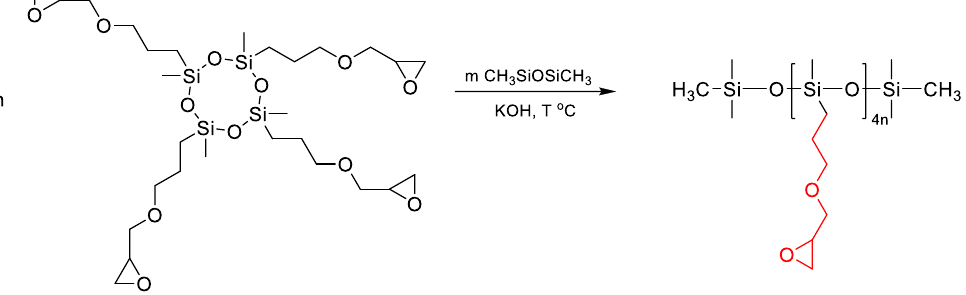
Figure 31. Ring-opening oligomerization of D4 R in the presence of potassium hydroxide.